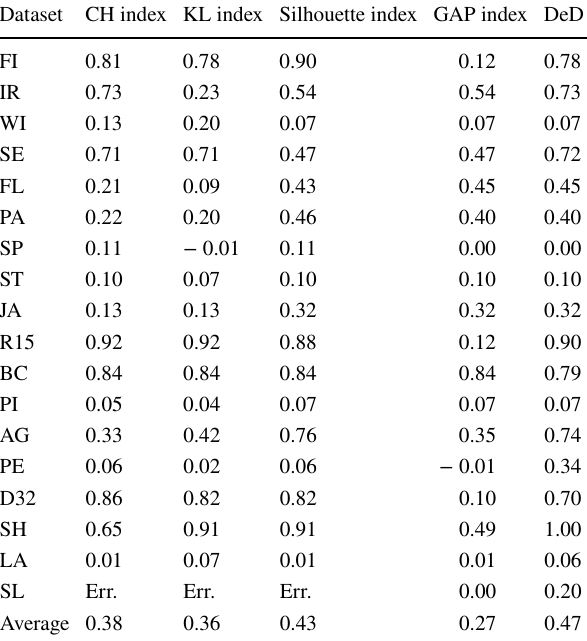
Table 6 Relative errors of the estimation of the number of clusters in relation to the known number of classes